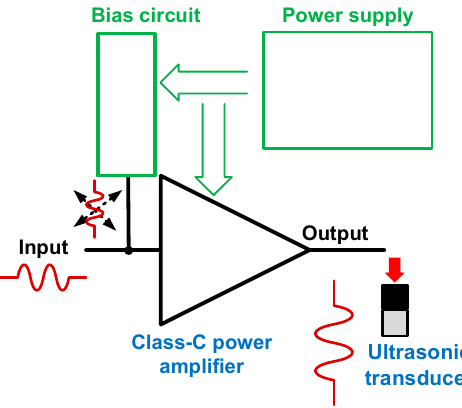
Figure 1. Concept for class-C power amplifiers with input pulse signals and bias circuit.